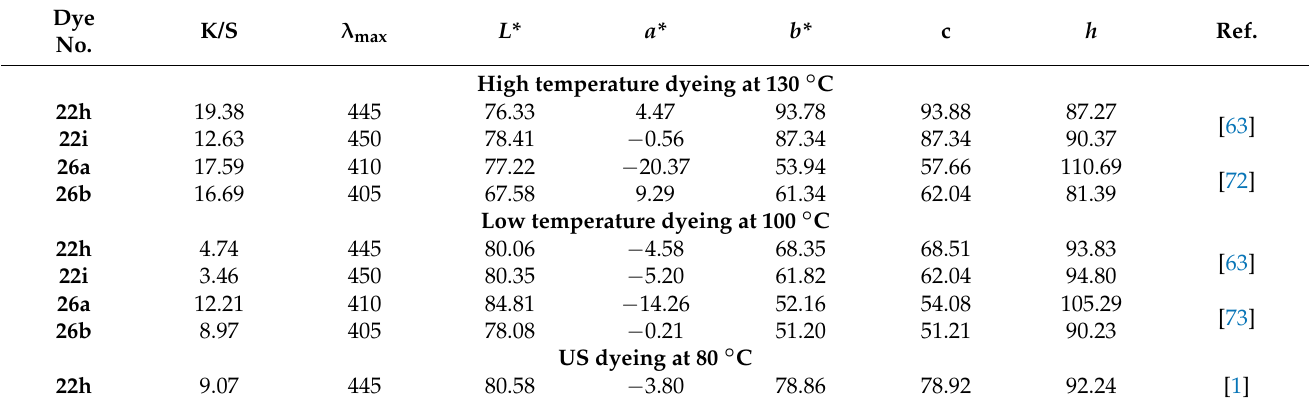
Table 2. Color strengths of the untreated polyester fabrics